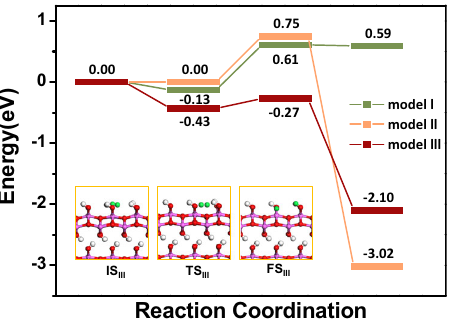
Fig. 7 DFT calculations of activation of H 2 molecules on AlOOH. The H 2 adsorption and dissociation pathways on the surface of AlOOH in different